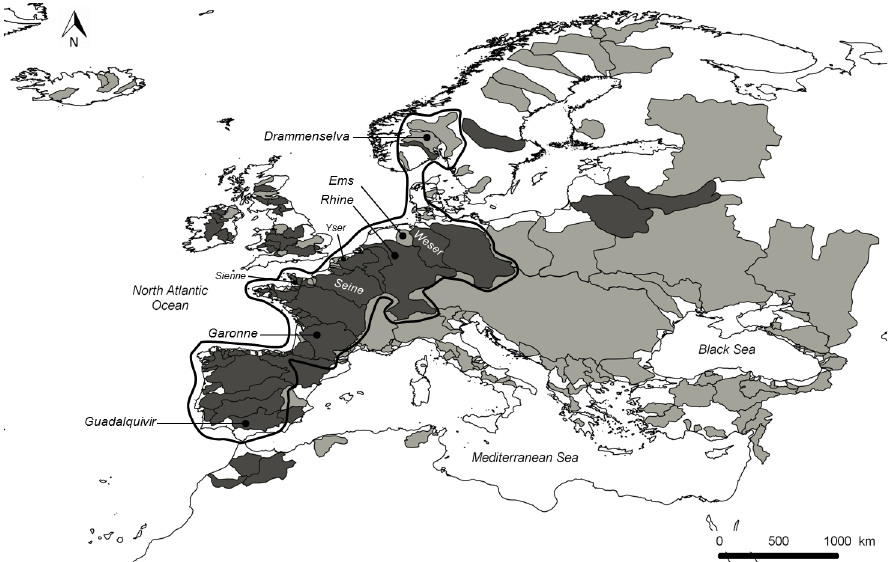
Fig 2. The geographical extent of the correlative and mechanistic modelling approaches with the allis shad historical distribution. Light grey and dark grey polygons corresponded to the 197 basins of EuroDiad 3.2 considered in the correlative SDM. Light grey and dark grey polygons represented also the allis shad former absences and presences around 1900, respectively. The area delineated by a solid black line denoted the 73 basins taken into account in the GR3D model